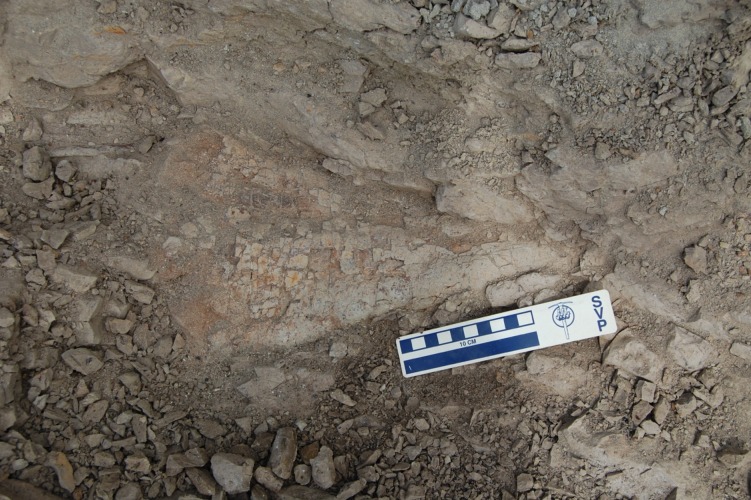
Exposed end of Centrosaurus tibia upon initial discovery.